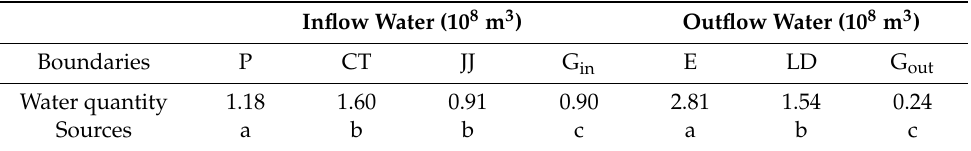
Table 3. Water balance of inflow and outflow of Chagan Lake in 2018.